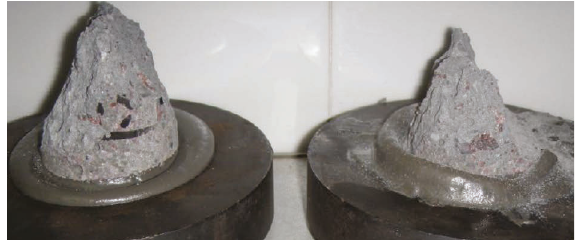
Figure 24: The failure of specimens under dynamic pressure.